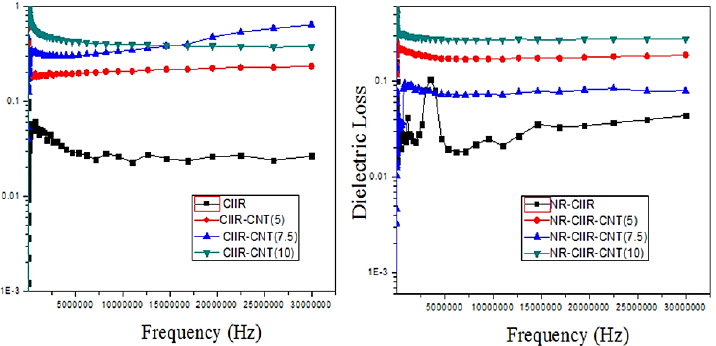
Figure 15. Dielectric loss tangent frequency dependencies of CIIR and CIIR/NR rubber nanocom- posites with different filler concentrations. ites with different filler